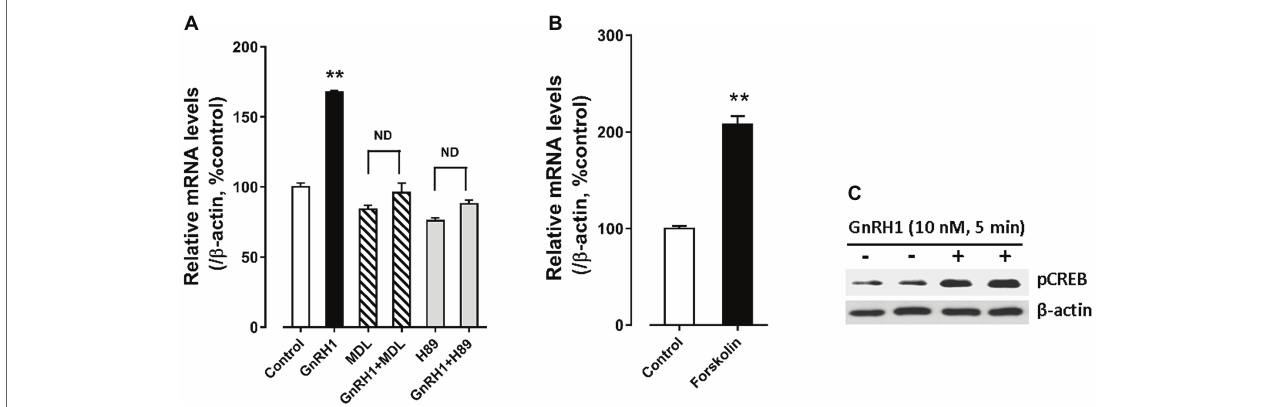
FIGURE 8 | (A) Effects of MDL12330A (MDL, 20 μM) and H89 (10 μM) on GnRH1 (10 nM, 24 h)-induced CART mRNA expression. (B) Effect of forskolin (2 μM, 24 h) on basal CART mRNA expression. “ND” indicates no statistical difference between the two groups. Each data point represents mean ± SEM of four replicates ( N = 4). ** p < 0.01 vs. control. (C) Western blot showed that GnRH1 (10 nM, 5 min) could enhance CREB phosphorylation (pCREB) in cultured chick pituitary cells. The β -actin in cell lysates were also examined and used as internal controls. The representative sets of independent experimental duplicates are shown here.